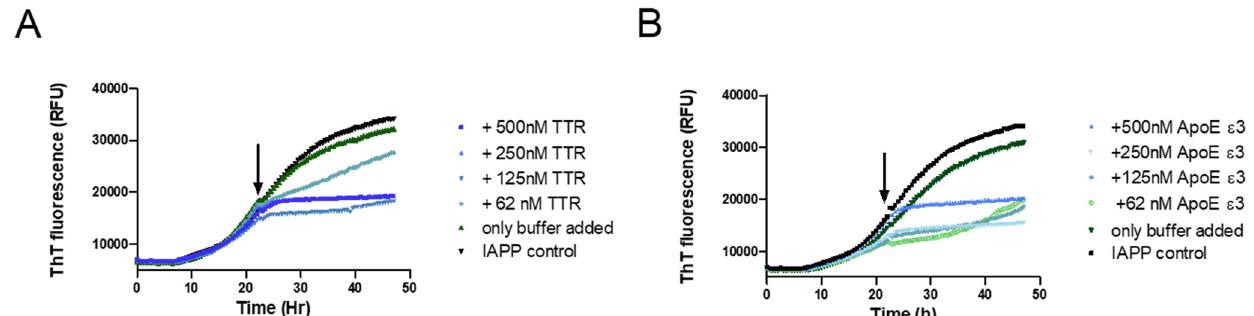
Figure 4. Probing the ability of TTR to inhibit the elongation process during IAPP amyloid formation. A total of 5 μ M of IAPP was incubated in phosphate-buffered saline and monitored for amyloid formation with the ThT fluorescence assay. At the timepoint indicated by the arrow, the respective proteins were added at the indicated concentrations: TTR L12P ( A ) recombinant Apolipoprotein E (ApoE) ε 3, serving as a positive control ( B ).